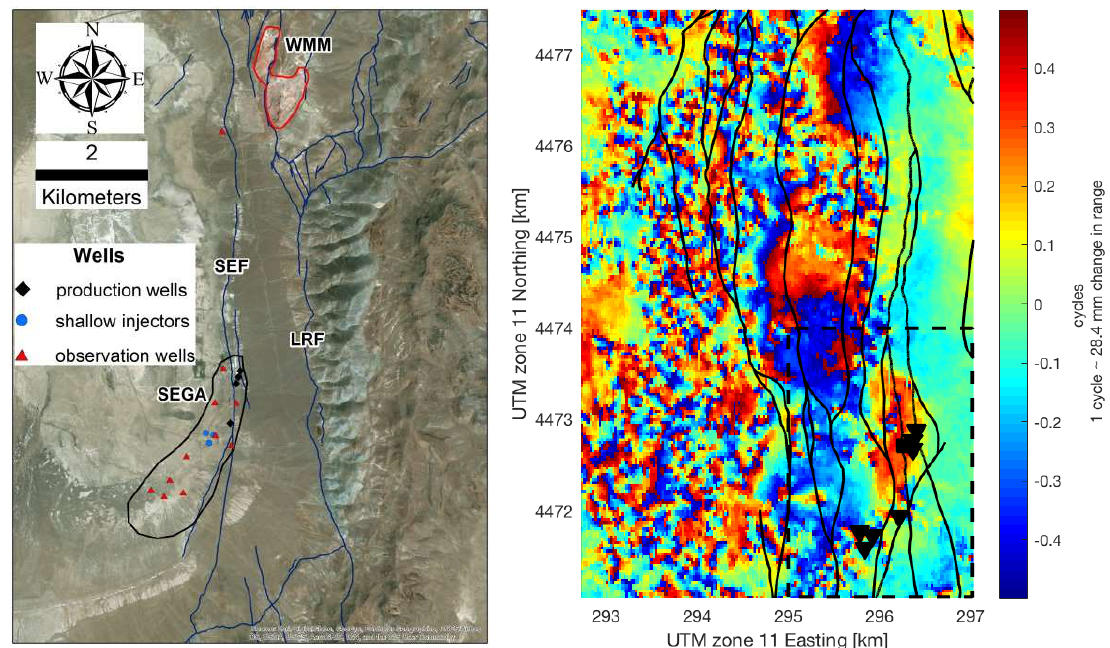
Figure 1. ( left ) Figure 1 from Warren et al. [14] (reproduced with permission): “Southeastern San Emidio Desert and the San Emidio Geothermal Area (SEGA), Washoe County, NV. LRF—Lake Range fault; SEF—San Emidio fault; WMM—wind mountain mine. Active and monitor wells show the extent of the currently defined resource area which is open to the south and west. Bleached and Fe-stained rocks along the SEF and LRF and in the vicinity of the WMM are hydrothermally altered. Green–blue–gray exposures in the footwall of the west-dipping LRF are Mesozoic metamorphic rocks which are overlain by Tertiary rocks that dip to the east. Dark blue faults are from Rhodes [11].” ( right ) Deformation field at San Emidio in terms of wrapped range change in cycles from an Envisat track 27 pair spanning 10th November 2004 to 10th September 2008. One cycle of wrapped phase corresponds to a range change of approximately 28 mm. The dashed rectangular region in the SE denotes the region used for deformation analysis in this study. Faults are denoted with black lines. Inverted triangles are injection wells and upright triangles are production wells. The power plant is denoted with a black square. Coordinates are easting and northing kilometers in universal transverse mercator (UTM) projection zone 11N, WGS84